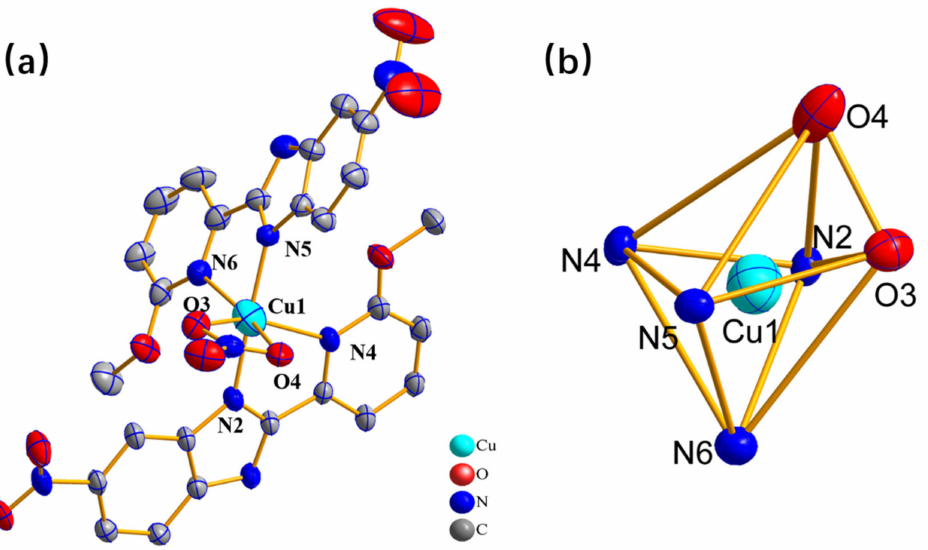
Figure 1. ( a ) The crystal structure of the complex 1 . ( b ) The spatial configuration of the complex 1 , all are 50% probability ellipses. Color codes: green, Cu; red, O; blue, N; gray, C; and hydrogen atoms are omitted for clear